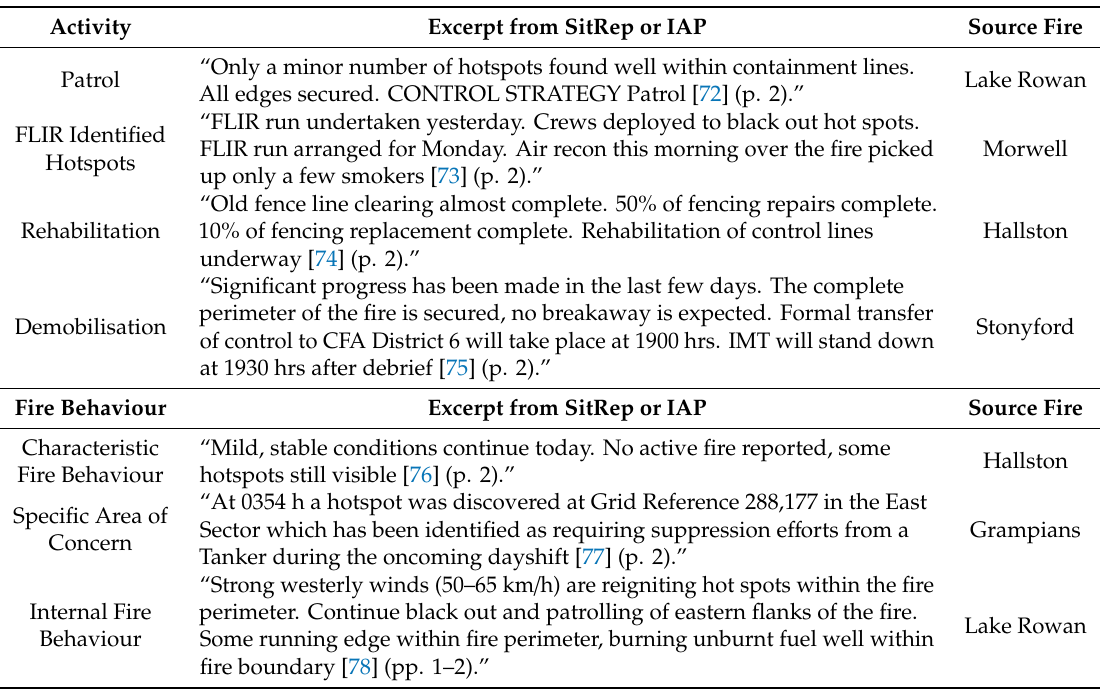
Table 7. Illustrative excerpts of suppression and fire behaviour in the patrol